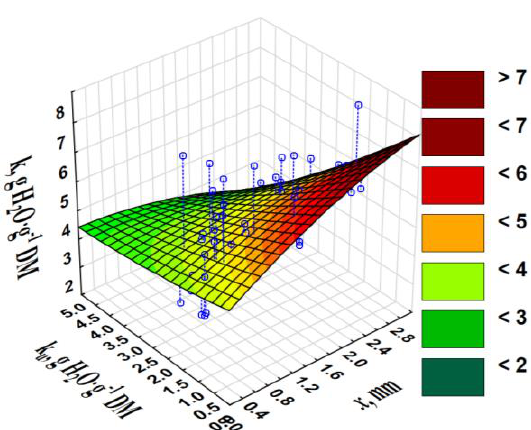
Figure 5. Water absorption by crushed pellets k vs. fraction particle size x and water absorption by uncrushed pellets k u .